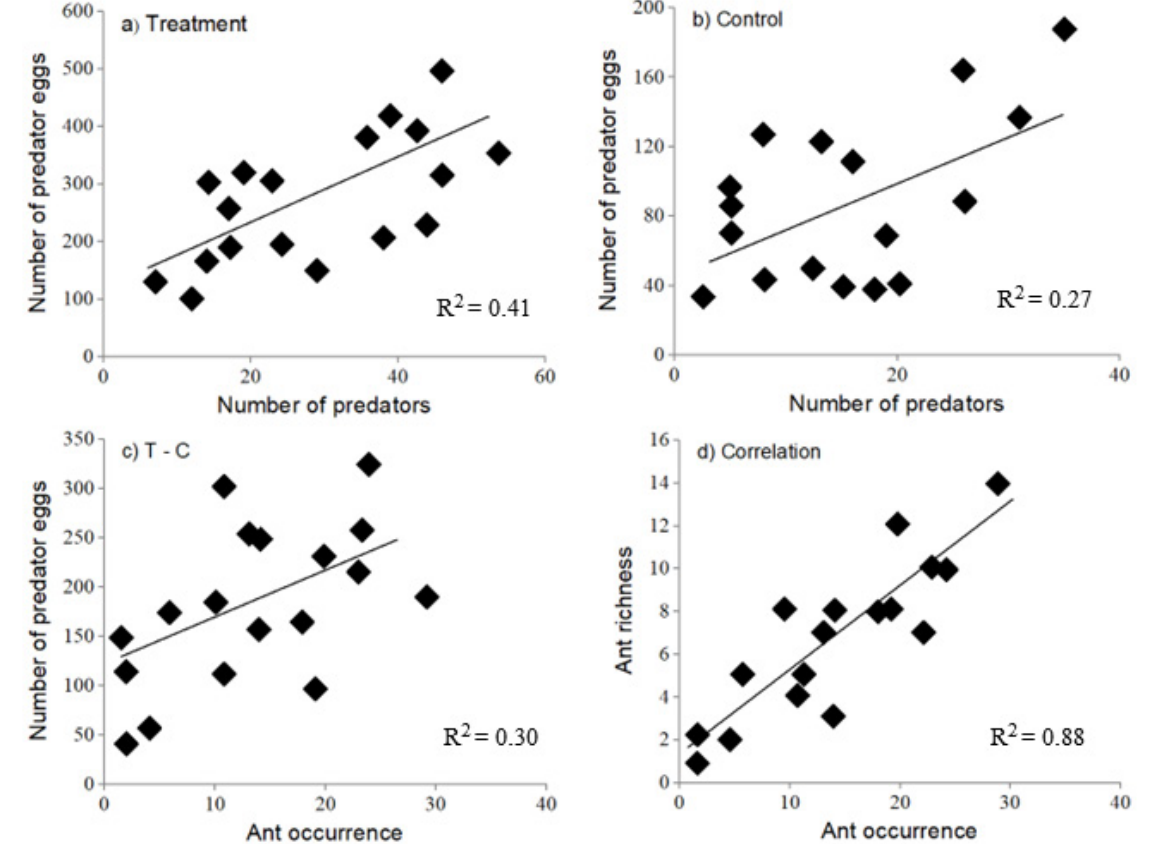
Fig 6. Linear relationships between abundance, predation or richness, such that: (a) eggs predated on the cards treatment in relation to all predators; (b) eggs predated on control cards in relation to predators except ants; (c) eggs predated in the treatment minus the control (predation attributed to ants) in relation to the occurrence of ants; and (d) correlation between ant richness and its occurrence. For all regressions and correlation, the results were significant ( p <0.05). These data are based on the experiment carried out in 18 locations within the Rashad, Sudan, from